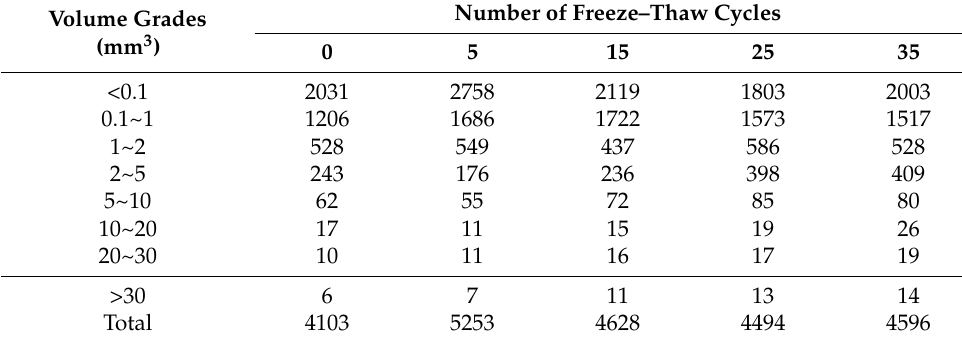
Table 6. Design voids content = 5%.